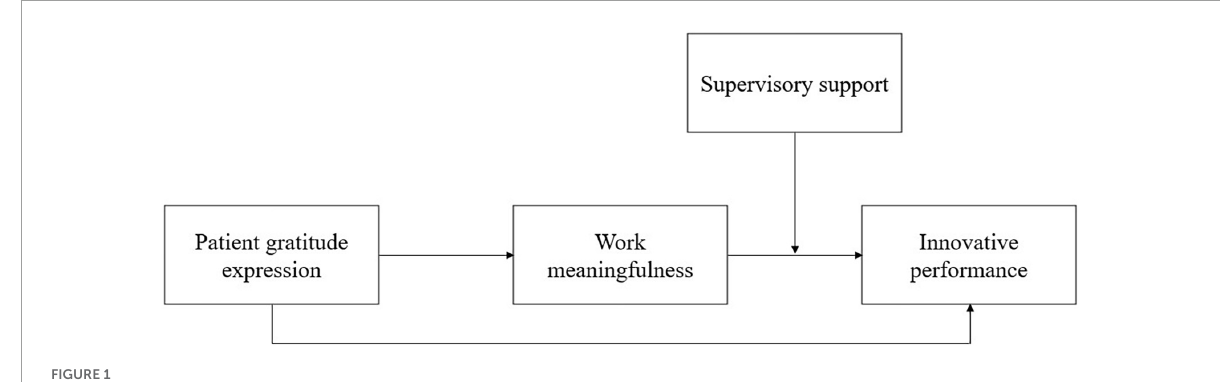
FIGURE1 Research